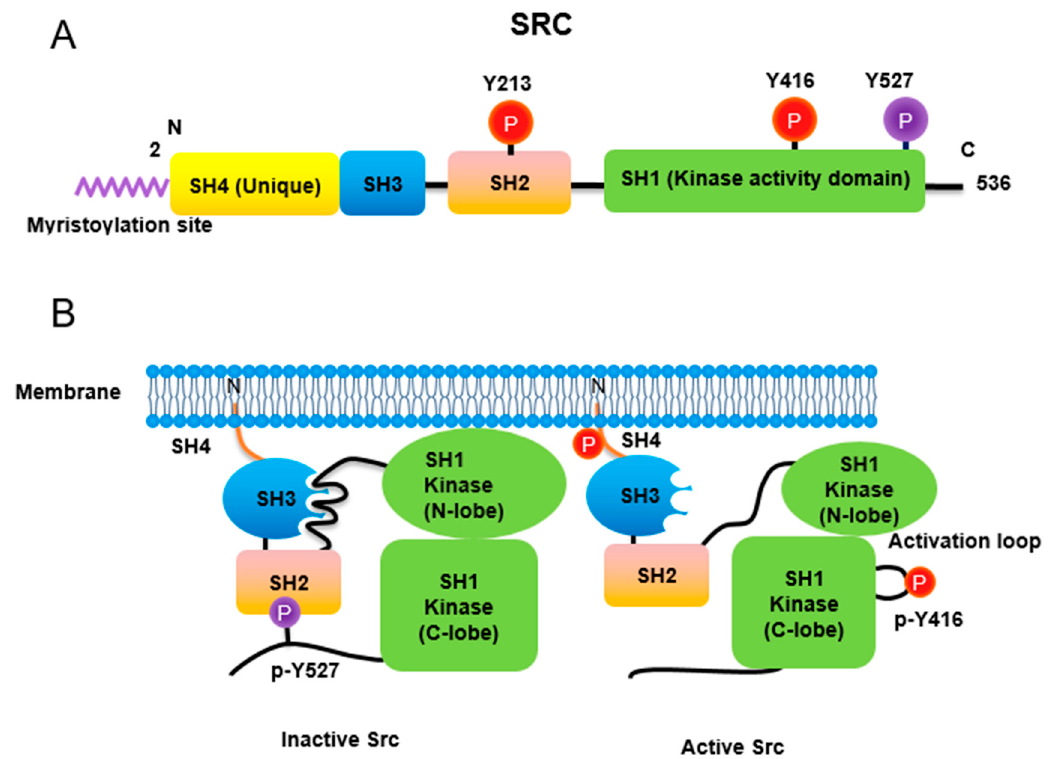
Figure 1. Regulation of Src non-receptor tyrosine kinase activity. ( A ) Src consists of several domains including SH1, SH2, SH3 and SH4 domains. Important Tyr phosphorylation sites of Y527, Y416 and Y213 are noted. ( B ) Tyr527 phosphorylated by C-terminal Src kinase (CSK) binds to SH2 domain in Src, leading to the inhibition of Src activity. Phosphorylated Tyr213 of Src interferes with SH2 domain binding to p-Tyr527 residue of Src. Dephosphorylation of Src Tyr527 by receptor protein tyrosine phosphatase α activates Src and Tyr416 phosphorylation acquires a fully activation.